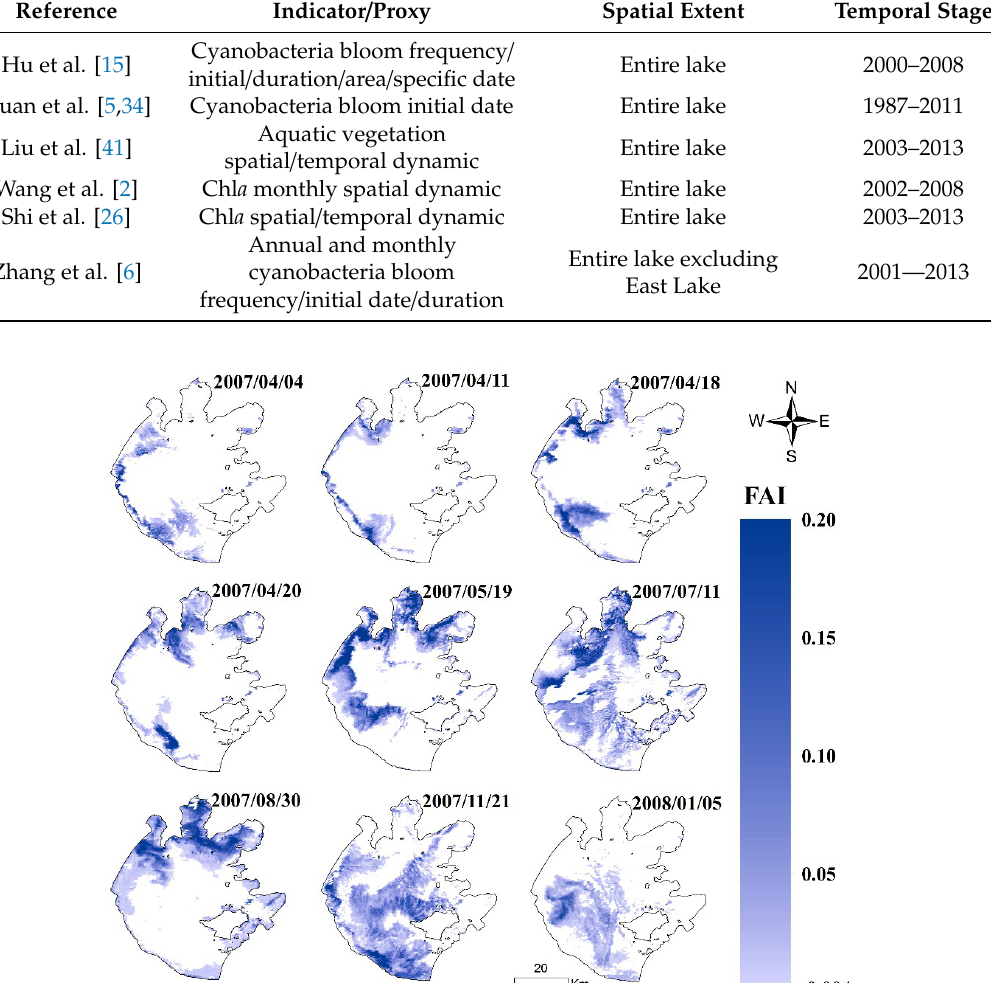
Table 3. Similar studies used for spatiotemporal pattern validation.